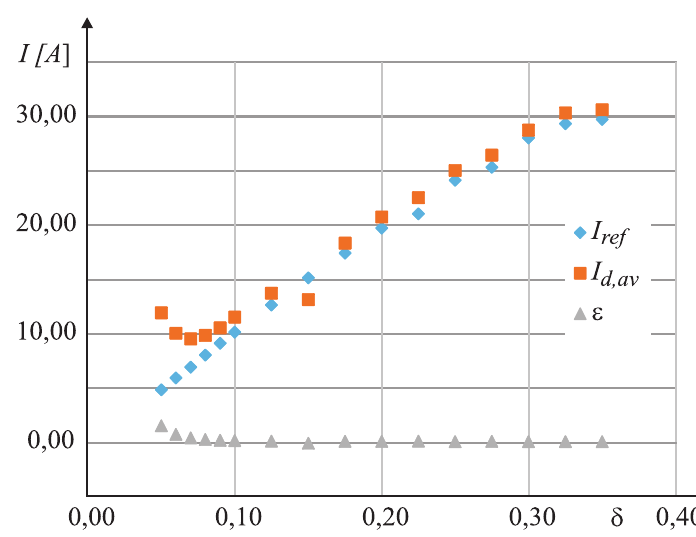
Figure 13. The static characteristics of reference measurement system and the proposed measurement algorithm